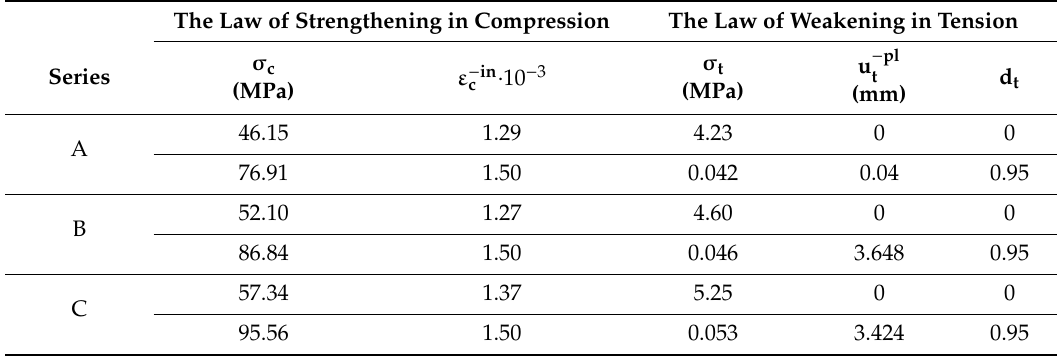
Table 6. Material constants adopted for the CDP model for di ff erent composite